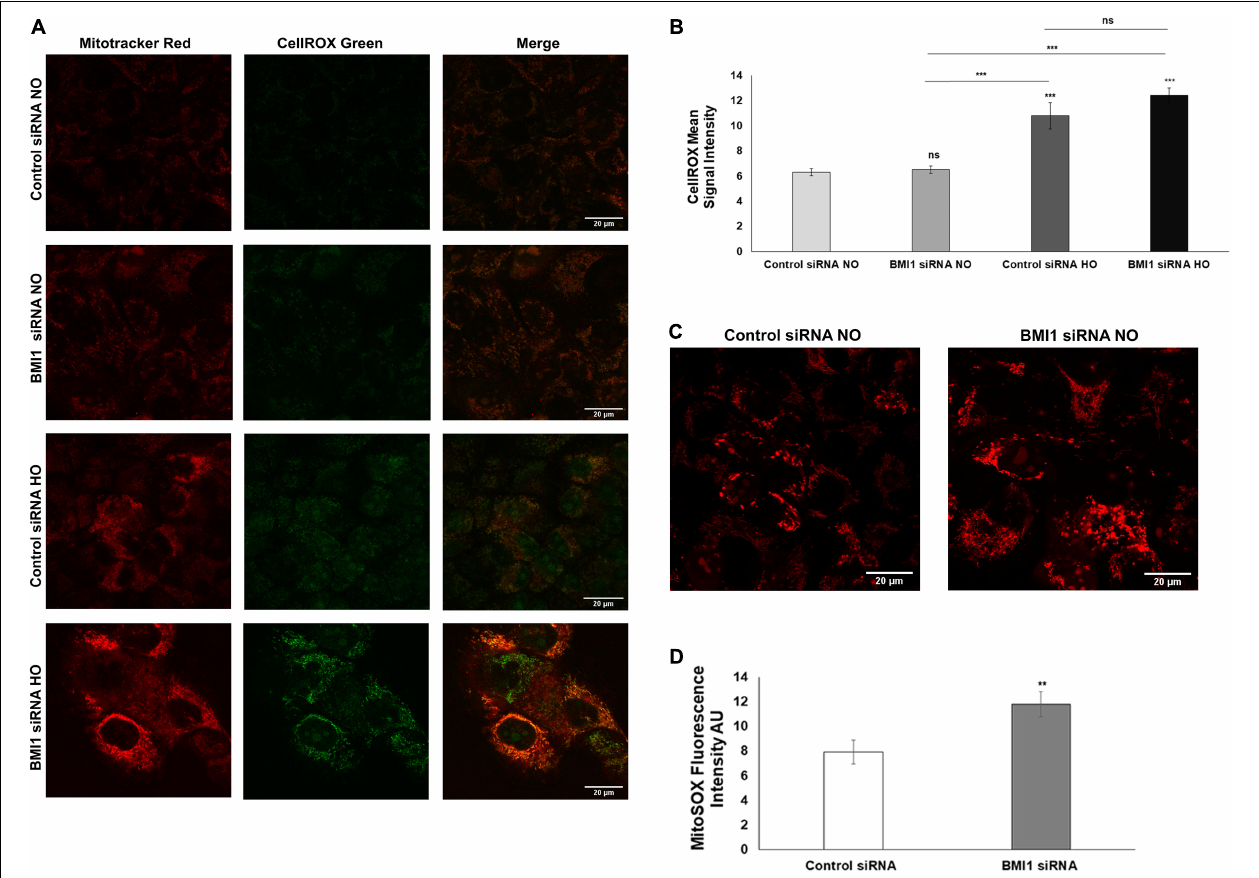
FIGURE 6 | Analysis of mitochondria oxidative stress in BMI1 silenced H441 cells. (A) BMI1 silenced and non-silenced h441 cells were stained with CellROX green and mitochondria were colocalized with MitoTracker Red. (B) Images were quantified and represented as CellROX mean signal intensity. (C) Reactive oxygen species (ROS) were detected in BMI1 silenced and non-silenced h441 in normoxia using MitoSOX Red (superoxide ion). A representative image is shown. (D) Quantification of ROS production in BMI1 silenced and non-silenced cells in normoxia is represented as Mito SOX = x fluorescence intensity (AU). Data represents mean ± SEM; two-ways MANOVA ns = no significant ** p ≤ 0.01, *** p ≤